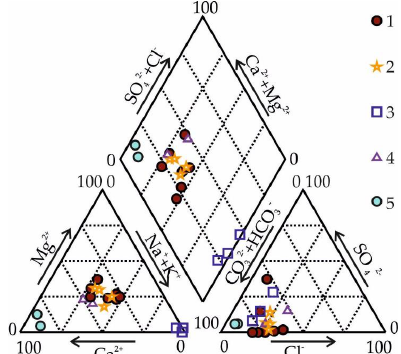
( Table 2 ). In summer, groundwater mineralization decreases to 0